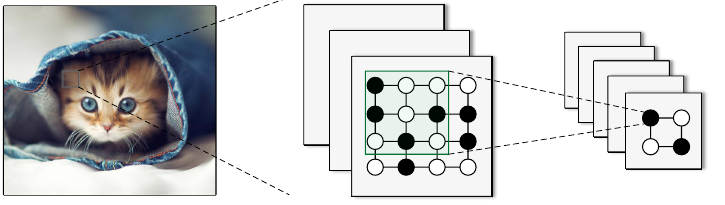
Figure 2. Single CNN layer with 3 × 3 filter. The filter slides over the feature maps of the image with a fixed step size. At each step, a 3 × 3 block of the feature map is taken, and the filter uses the block to calculate new features in a specific way (e.g., mean).